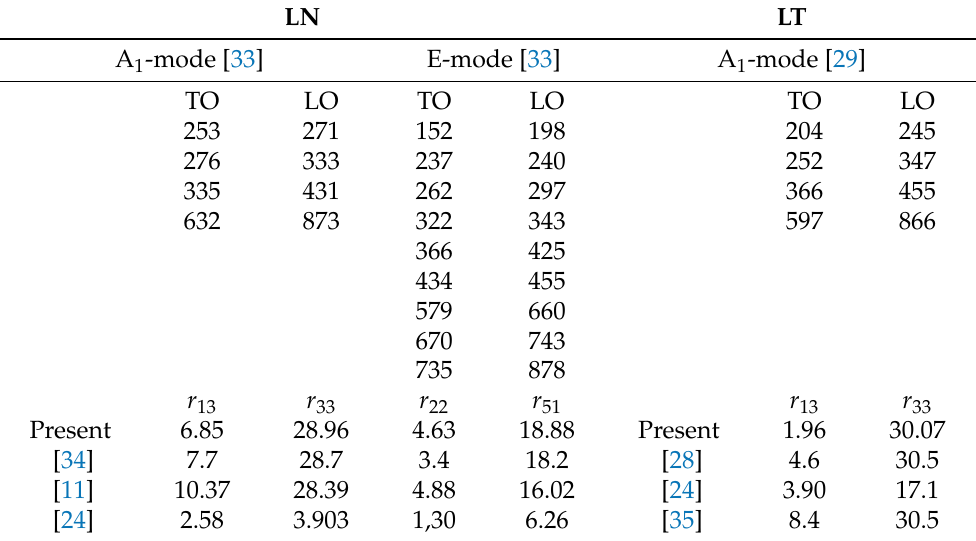
Table 1. TO and LO Raman frequencies (cm − 1 ) and calculated Pockels EO coefficients (pm/V) due to the A 1 and E normal modes and to the A 1 -modes in LN and LT crystals, respectively. Other EO coefficients are also displayed.